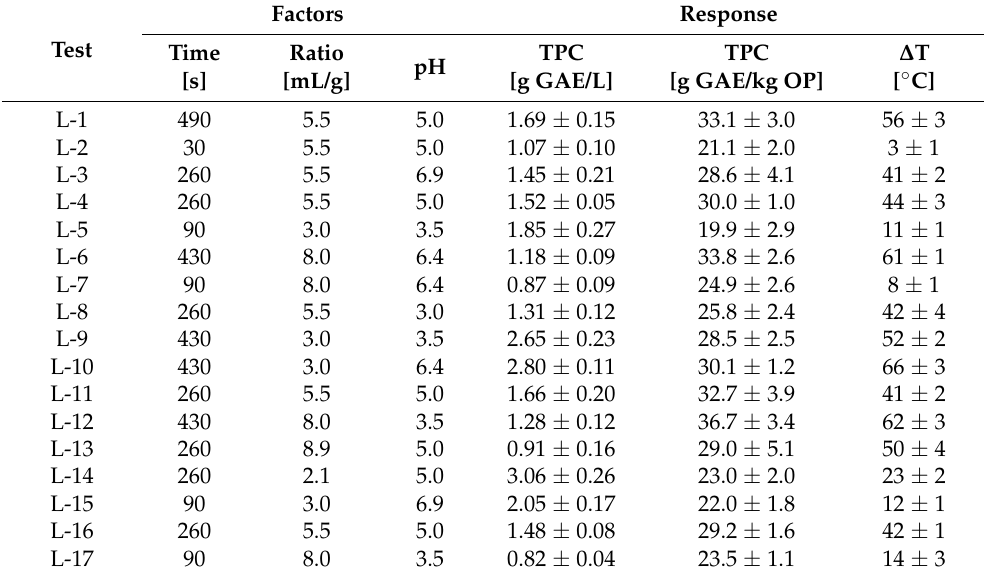
Table 1. Complete design of experiments for the UAE of polyphenols from OP at Laboratory scale. Factors Response Test